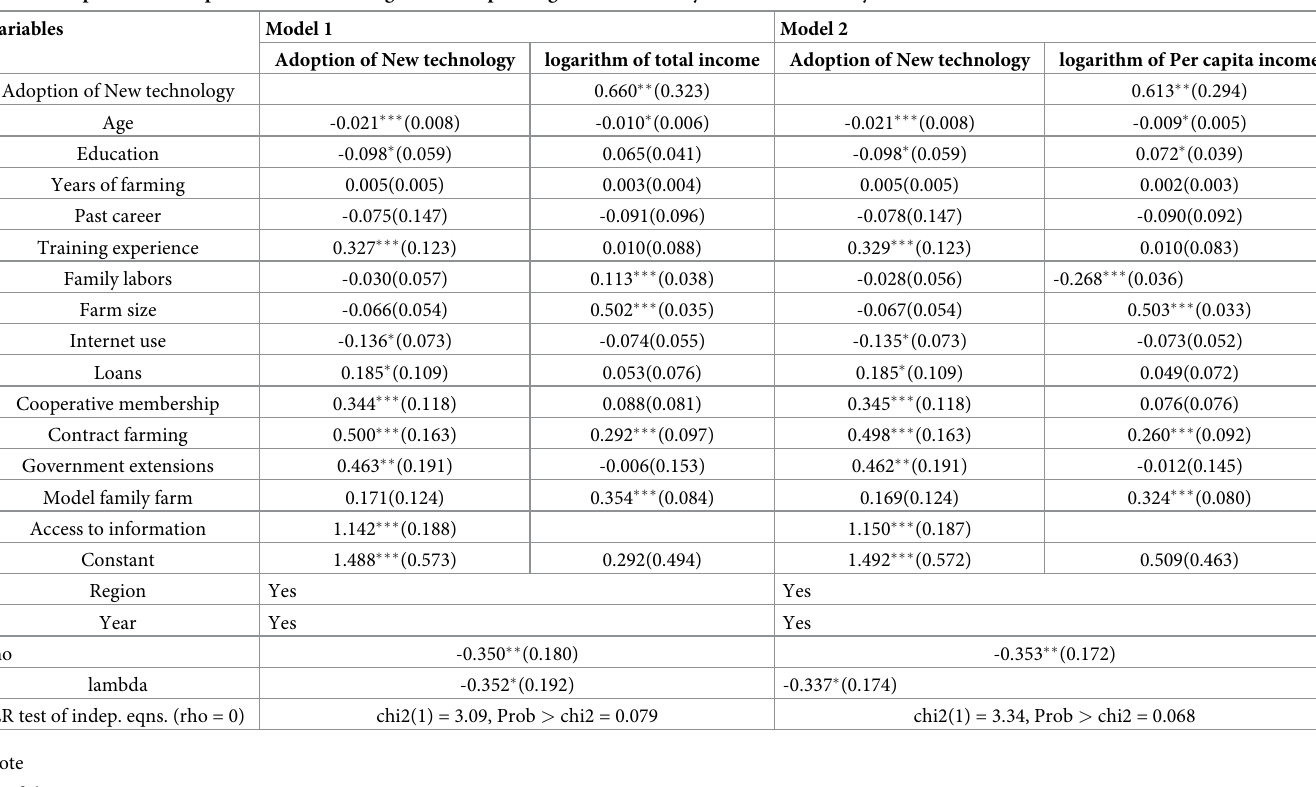
Table 8. Impact of the adoption of new technologies on the operating income of family farms: Estimated by the TEM model.